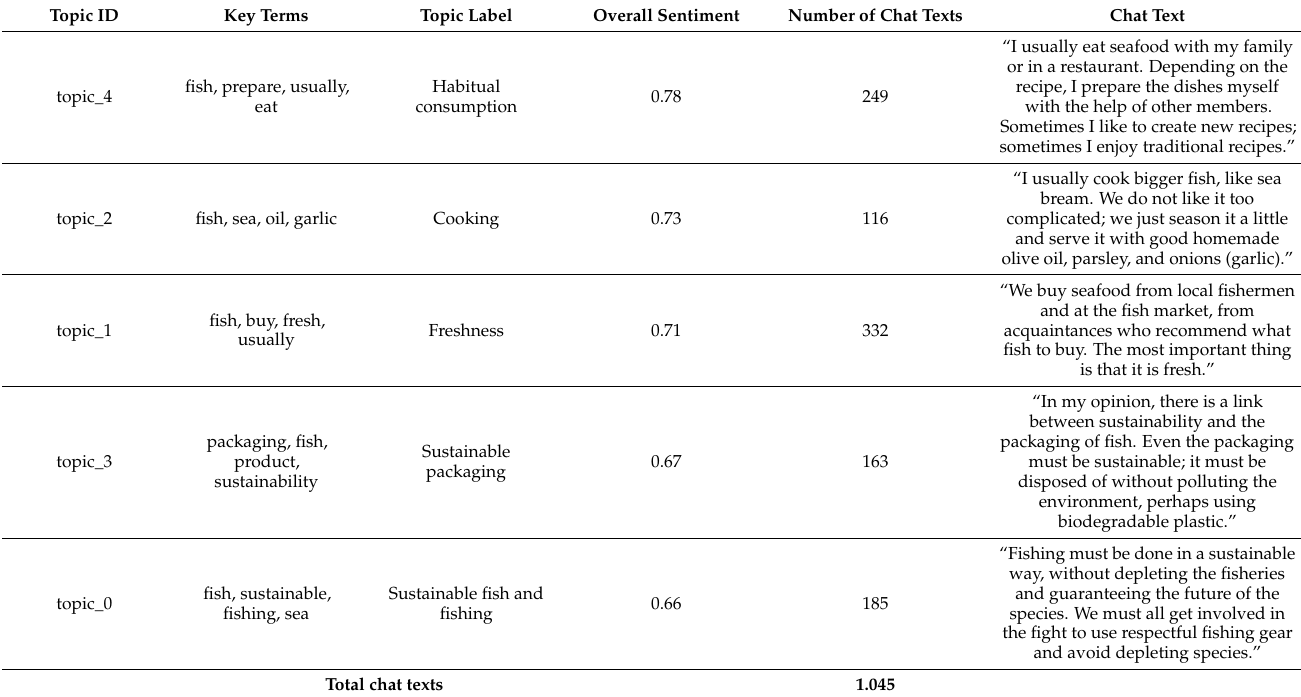
Table 3. Theme 1 topic and sentiment scores_ALL